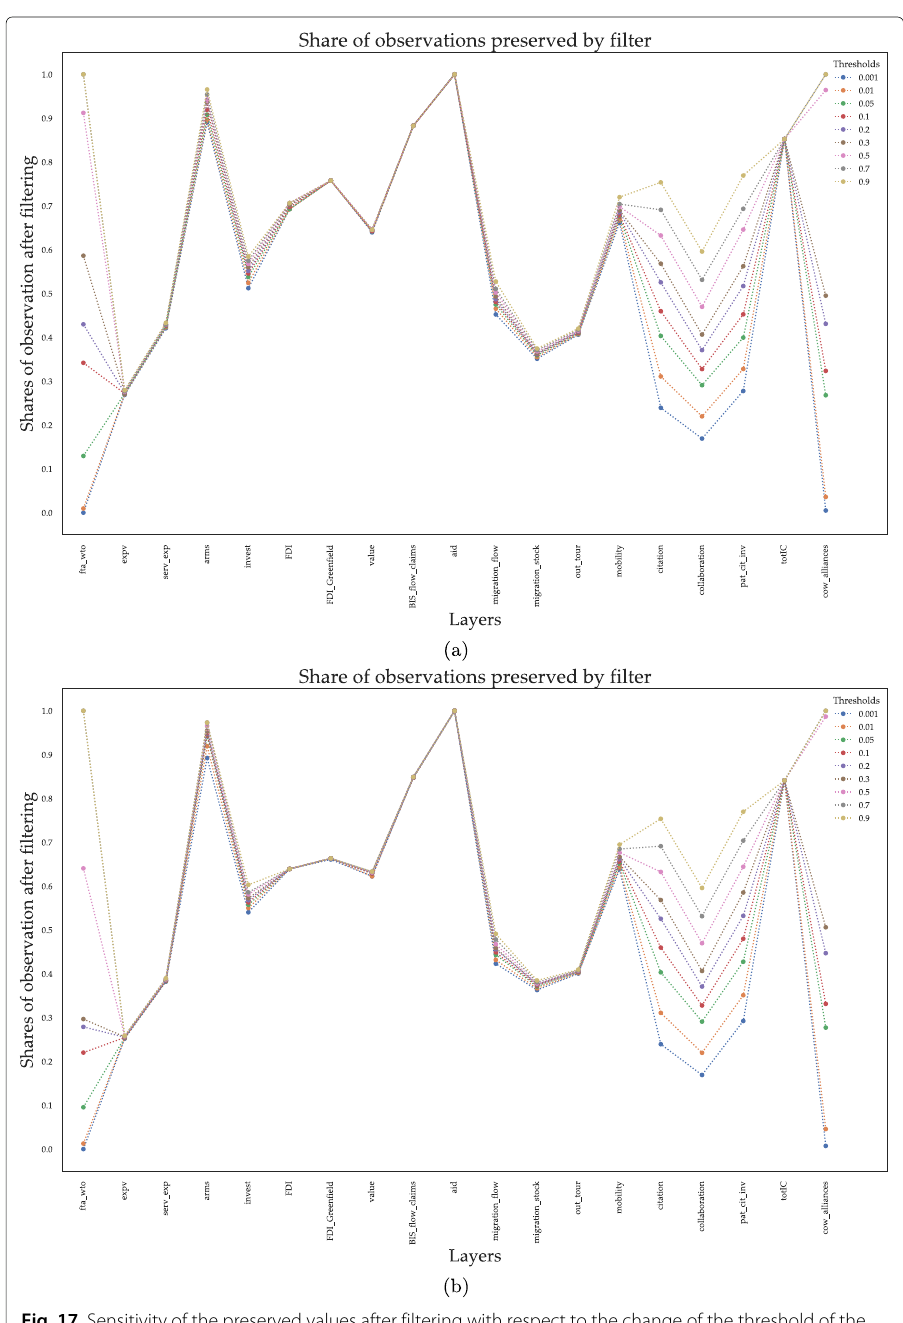
Fig. 17 Sensitivity of the preserved values after filtering with respect to the change of the threshold of the filter. Cross section in 2003 ( a ) and in 2010 ( b )